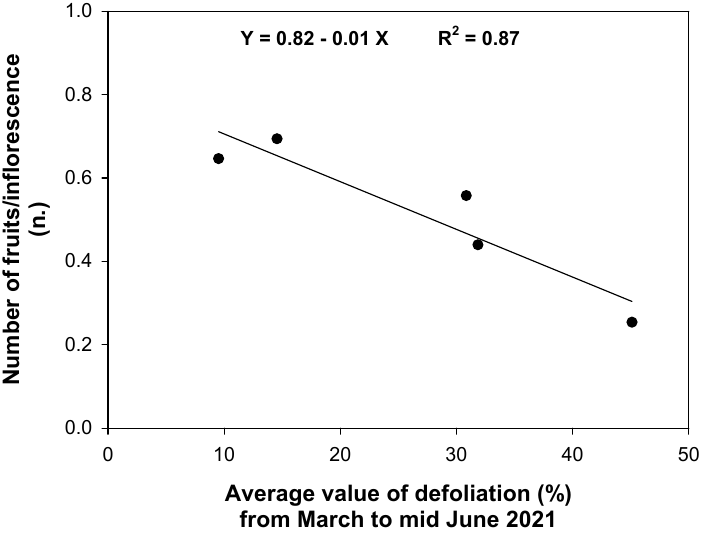
Figure 7. Relationship between the number of fruits/inflorescence formed in 2021 and the average defoliation of old leaves from March to mid-June. Furthermore, fruit weight (g/100 fruits) was negatively correlated to the average per- centage of defoliation of old leaves from mid-June to mid-September, as shown in Figure 8. This indicates that there was an indirect effect of V . oleaginea on the fruit dry weight.